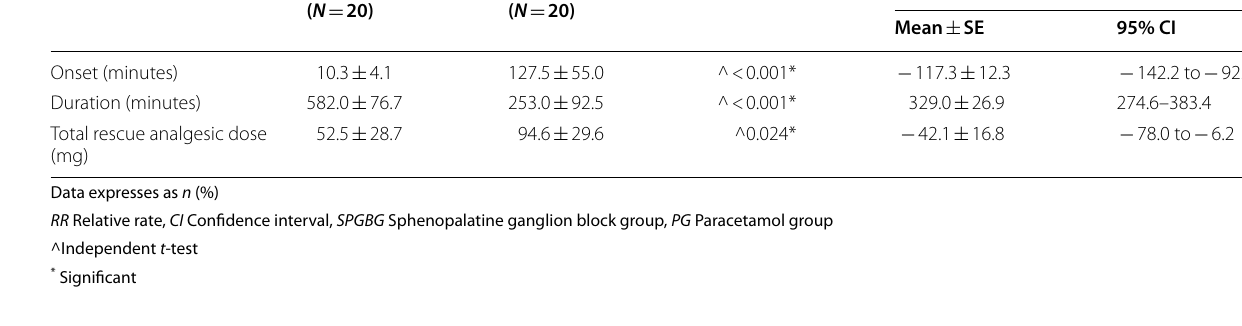
Table 4 Comparison regarding the onset, duration of analgesia, and total dose of rescue analgesic